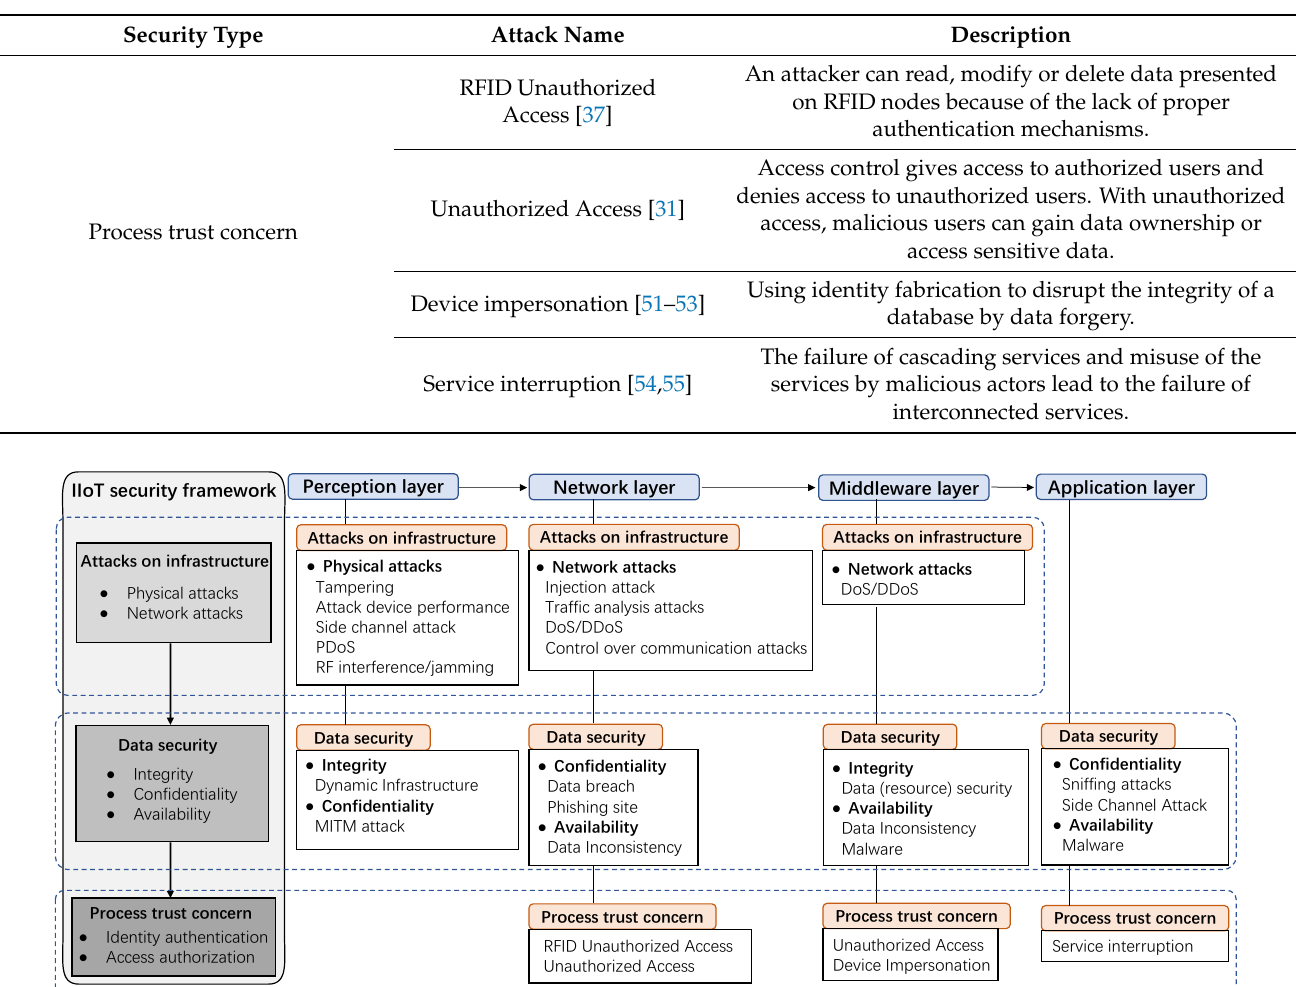
Figure 3. The framework of IIoT security issues. Table 1. The overview of IIoT security issues.